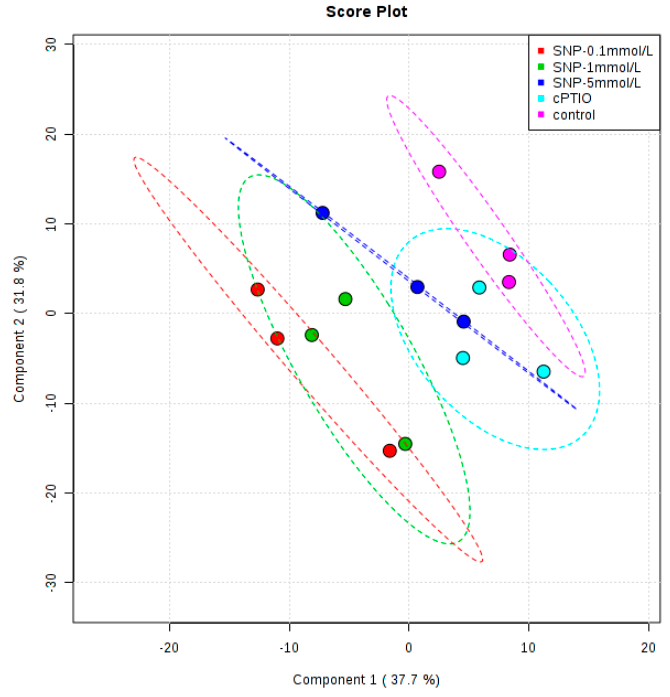
Figure 3. Scores plots of PLS-DA analysis showing the differences between the control and NO treatment.